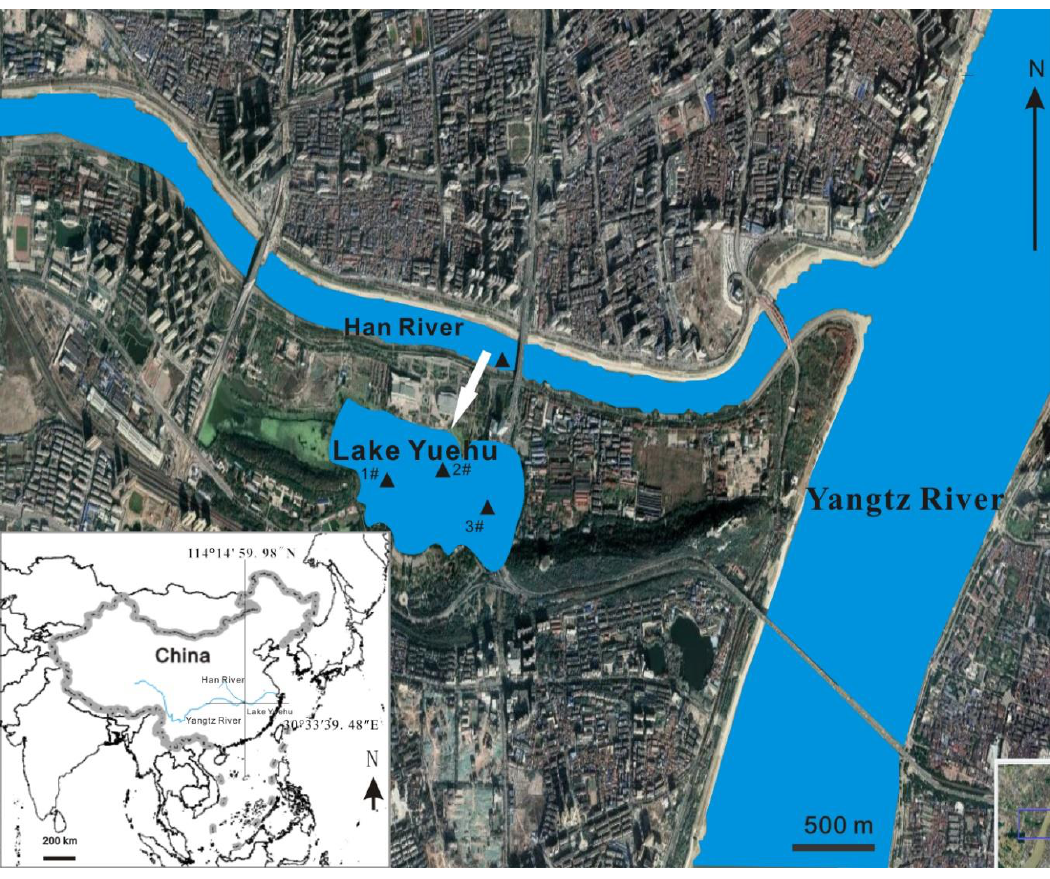
Figure 1. Location of Han River and Lake Yuehu. Triangles indicate the sampling sites.